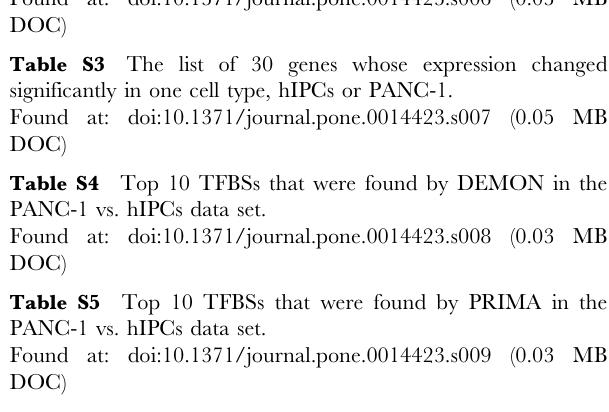
Table S2 Top 10 TFBSs that were found by PRIMA in the consensus data set and in the 30 consensus genes that exhibited increased transcription.